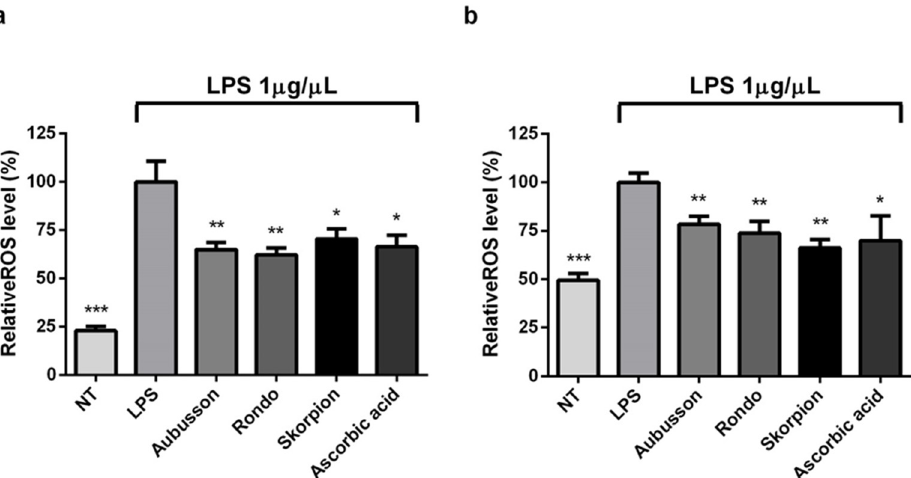
Figure 3. Effect of LMW peptides from doughs ( a ) and breads ( b ) on intracellular ROS. Cells were treated with 0.05 mg/mL LMW fractions for 1 h and then co-incubated with 1 µg/mL LPS for 24 h as reported in the material and methods section. NT: negative control, untreated cells; LPS: positive control, cells treated with only LPS; AA: cell treated with 0.05 mM ascorbic acid. Results are the mean ( ± SD) of three different experiments performed in duplicate. Statistical analysis was performed for each sample vs. the LPS value (* p < 0.05; ** p < 0.01; *** p <